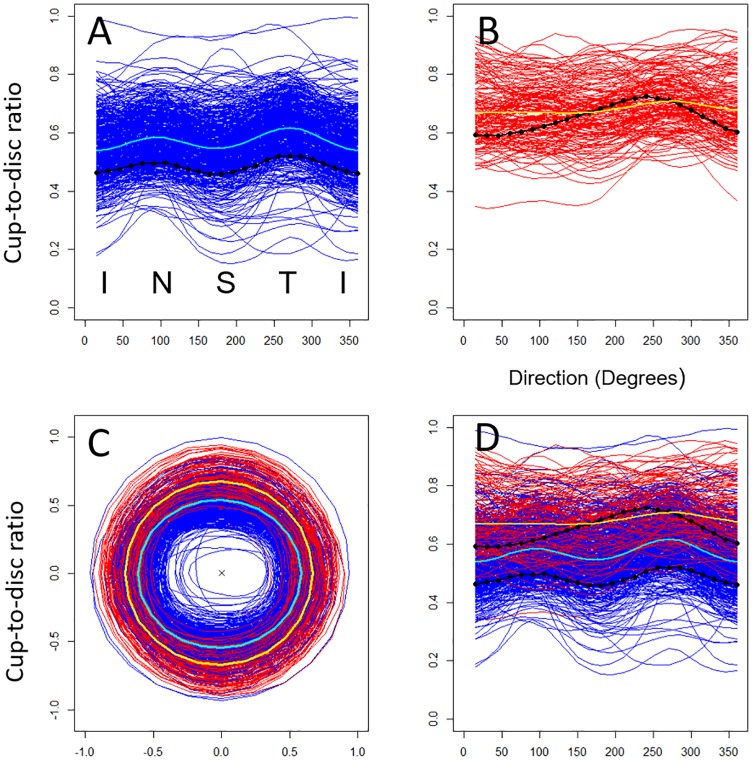
The cup/disc ratio profiles (pCDR) of all individual eyes from ORIGA.Individual healthy (A) and glaucomatous (B) optic nerve images from the ORIGA dataset (n = 650) in circular (C) and Cartesian (D) formats. These profiles come from semi-automated segmentation. The population mean pCDR for healthy (cyan) and glaucomatous (yellow) groups are shown together with the individual pCDR profiles of the two eyes from Fig 3 (black).